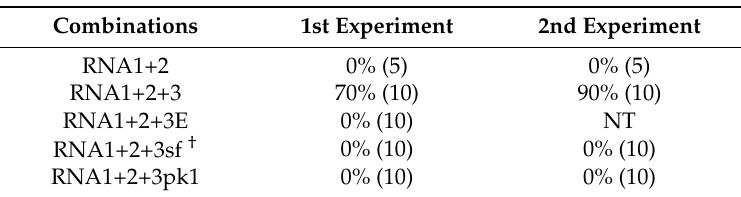
Table 1. Effect of the RNA3-derived species on the long-distance movement of BNYVV in Beta macrocarpa.